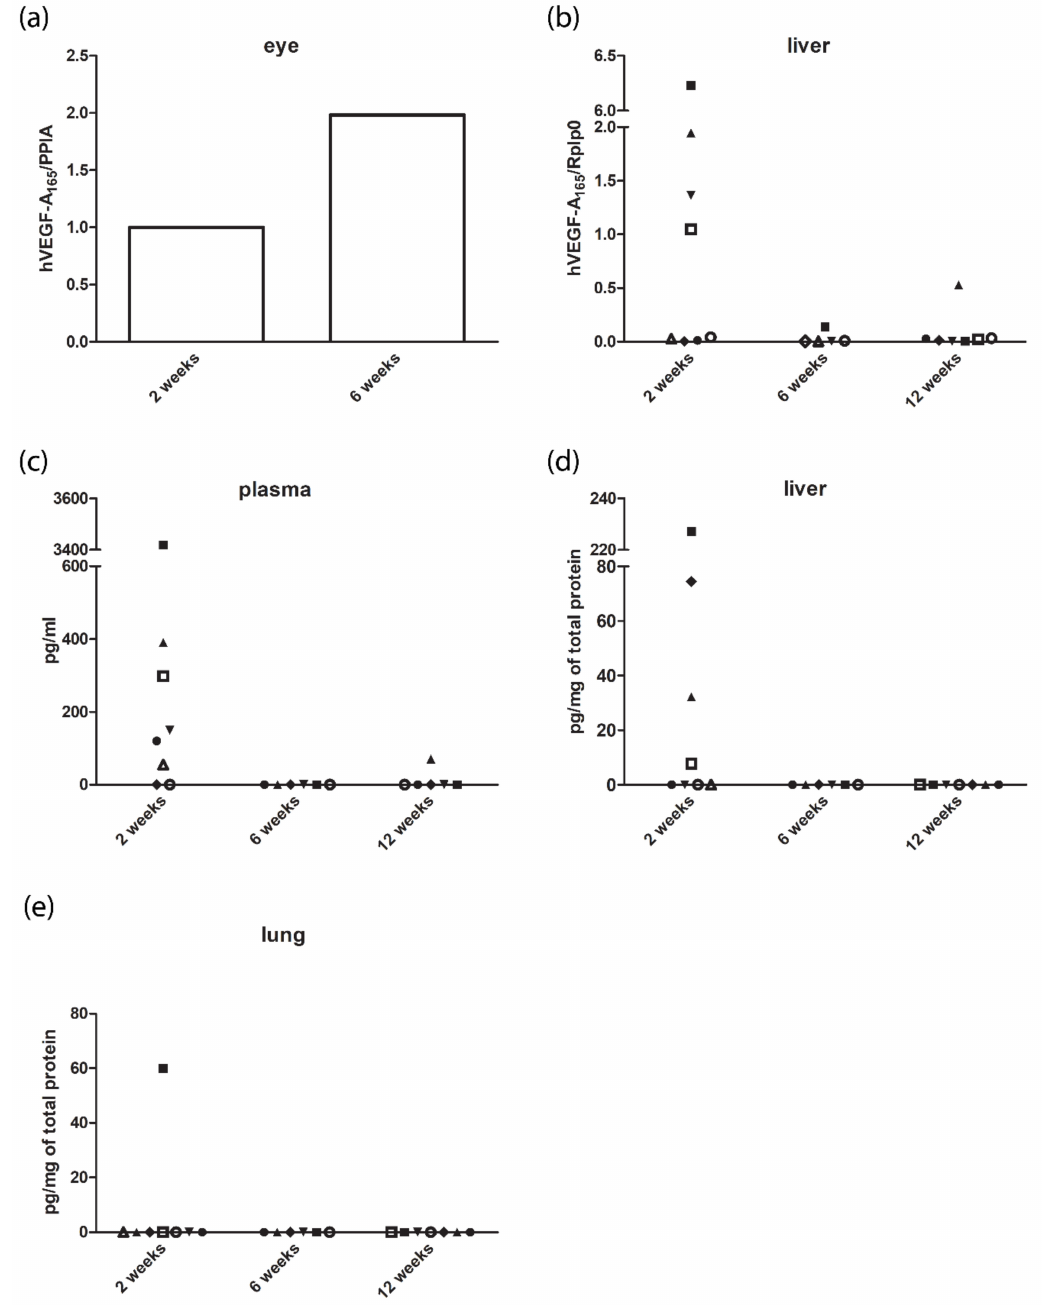
Figure 8. Human VEGF-A 165 messenger RNA (mRNA) and protein expression in the eye and off-targets. ( a ) Real-time polymerase chain reaction (RT-PCR) analysis of the expression of hVEGF-A 165 in whole eyes. Cyclophilin A (PPIA) normalized relative mRNA expression of hVEGF-A 165 was two-fold higher six weeks after Cre injection compared with the two-week time point. ( b ) RT-PCR analysis of the expression of hVEGF-A 165 in liver samples. Ribosomal protein lateral stalk subunit P0 (Rplp0) normalized mRNA expression of hVEGF-A 165 was the highest two weeks after Cre injection. ( c – e ) hVEGF-A 165 protein levels in plasma, liver, and lung homogenate after Cre gene transfer, respectively. The same symbols in each graph represent the same